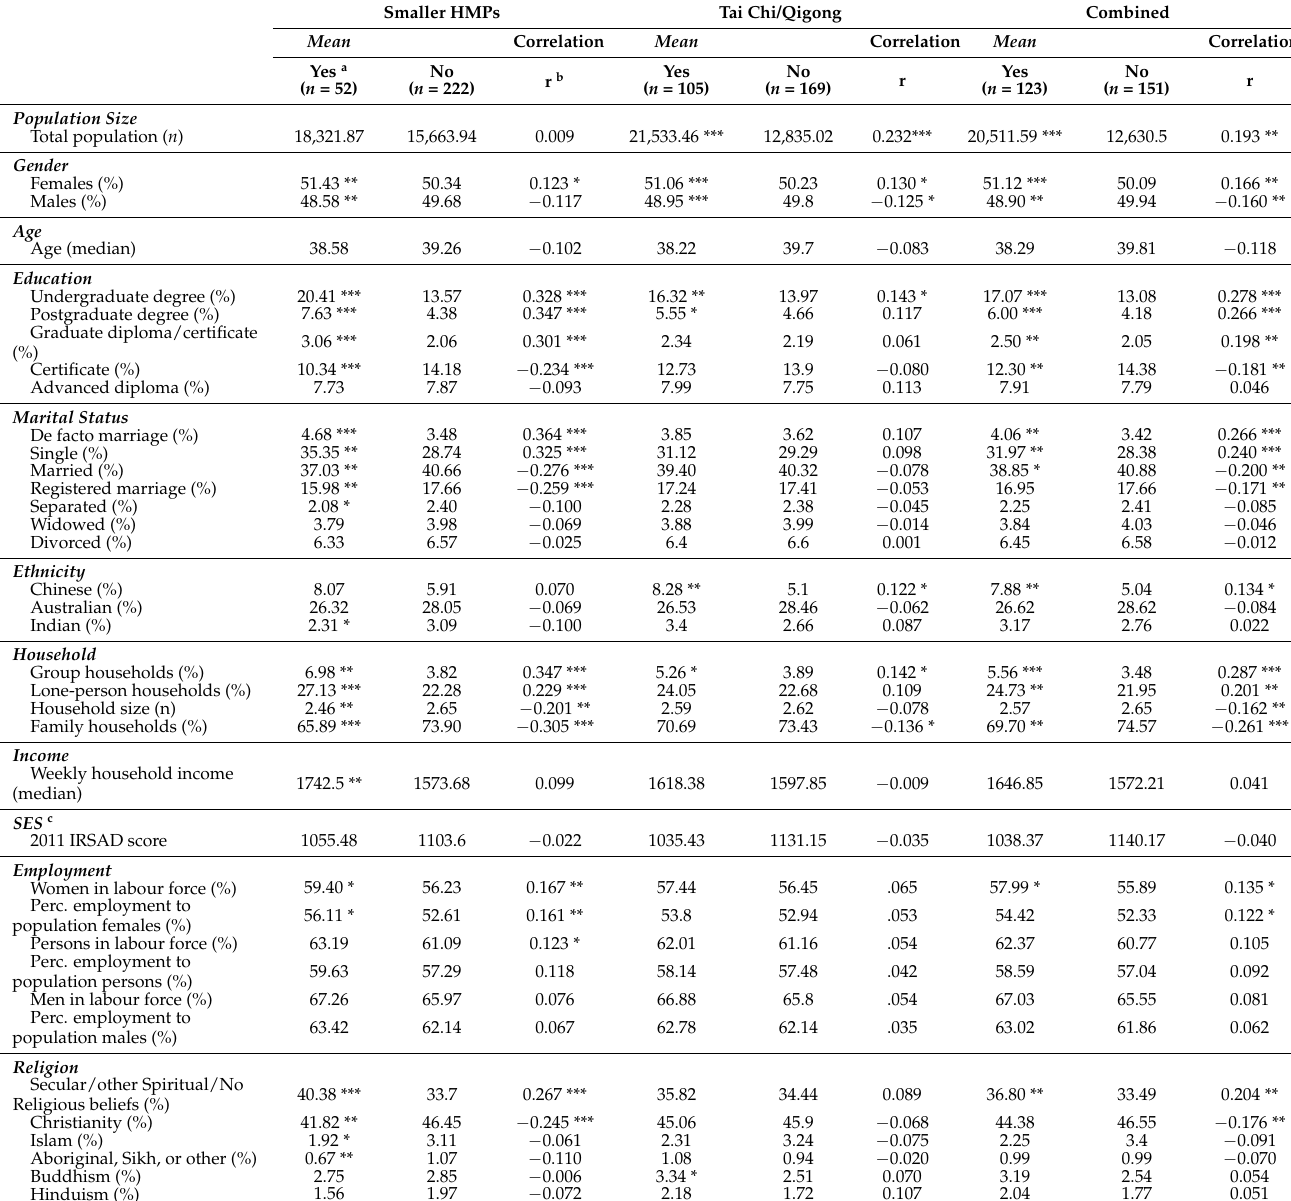
Table 5. Relationship of HMP-offering postcode areas with 2016 census